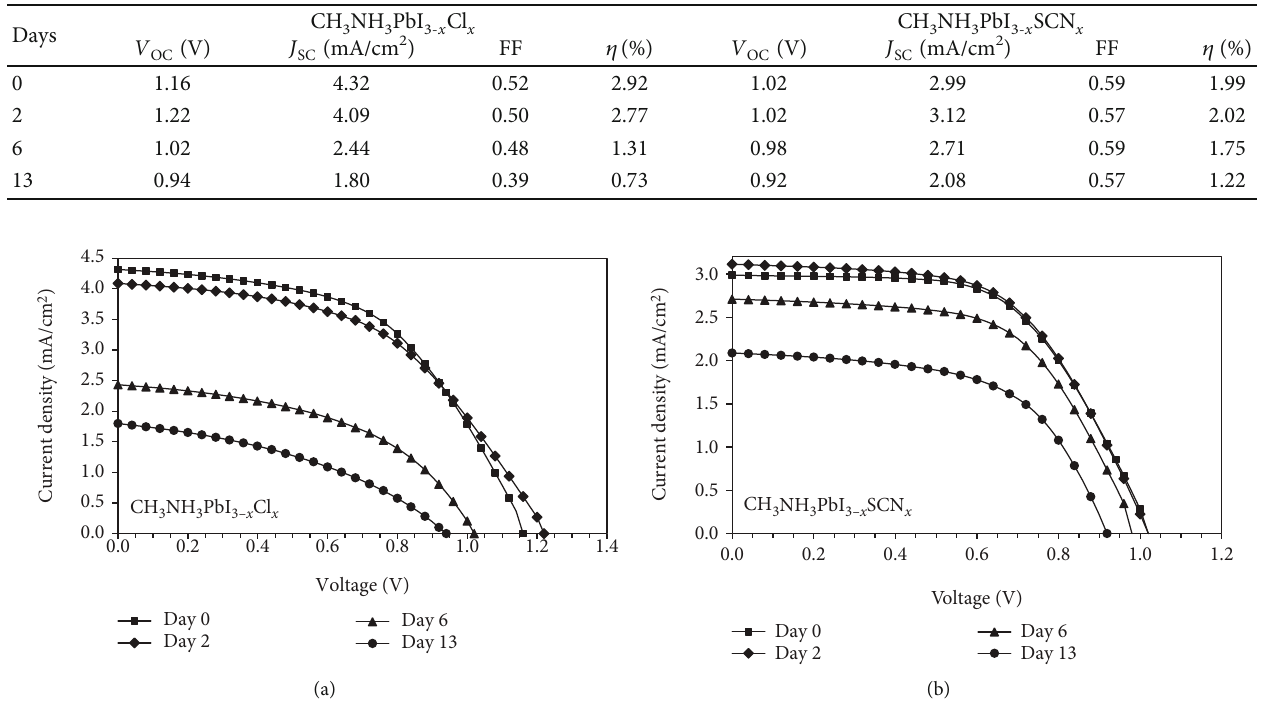
NH PbI Cl x and (b) CH NH PbI SCN x showing 3 3 3- x 3 3 3- x